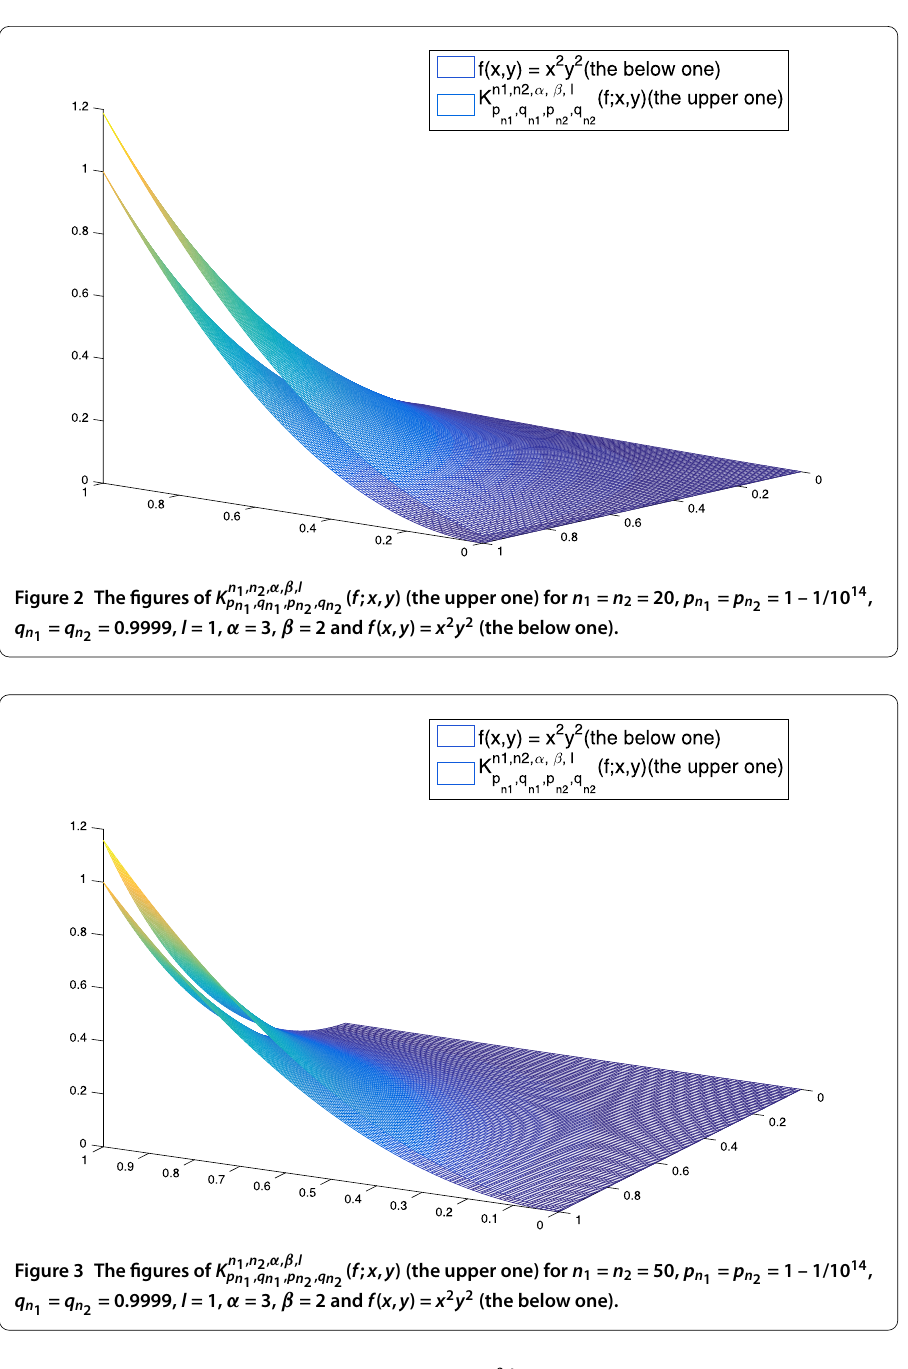
( f ; x , y ) for p n = p n = 1–1/10 15 , 1 2 n 1 , q n 1 , p n 2 , q n 2 ( f ; x , y ) (cid:2) 1 , qn 1 , pn 2 , qn 2